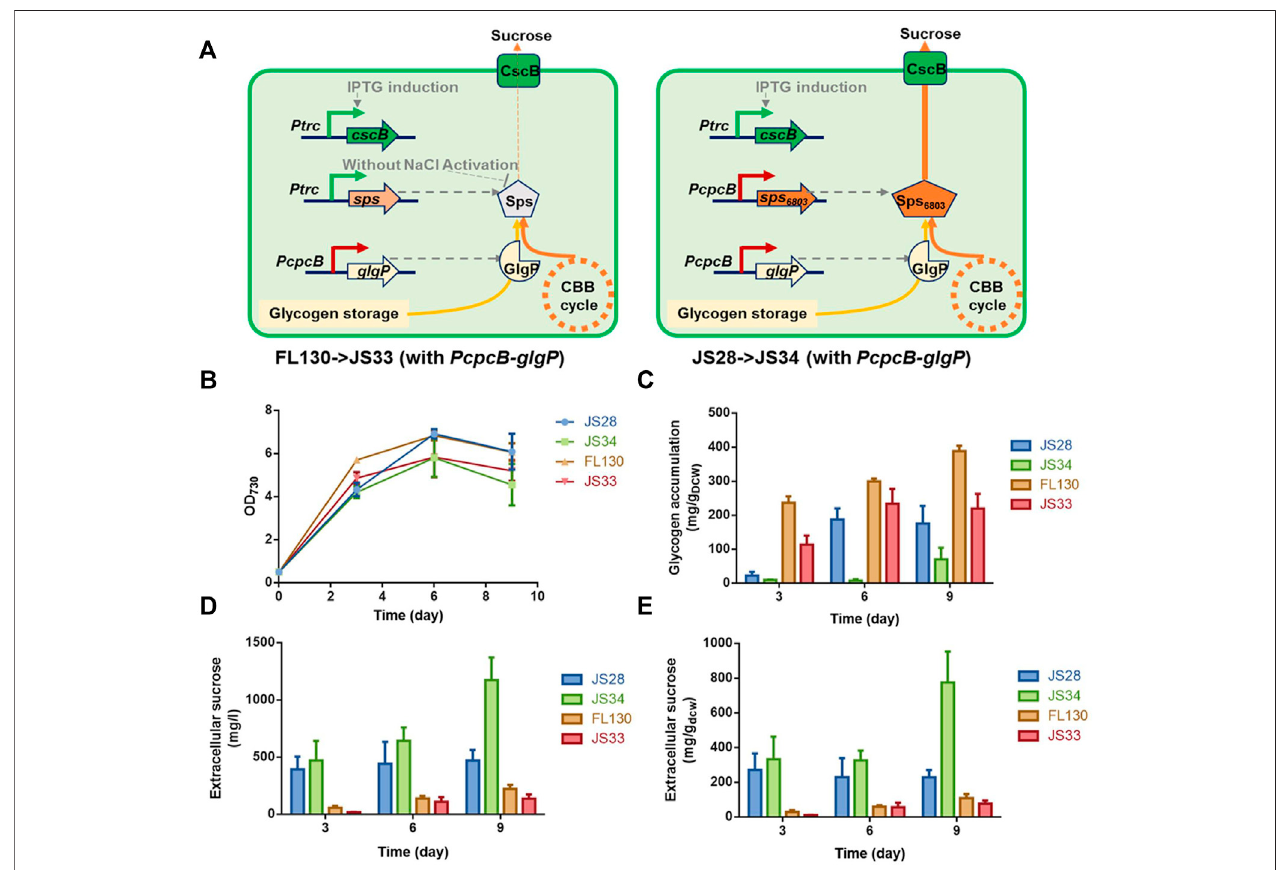
FIGURE 6 | Effects of glgP overexpression on sucrose synthesis of PCC 7942 cell factories under non-hypersaline conditions. (A) To facilitate sucrose synthesis under non-hypersaline conditions, the PCC 6803 sourced sps gene sps 6803 was put under the control of the PcpcB promoter to replace the Ptrc expressed native sps gene in FL130, and the obtained strain was termed as JS28. To enhance glgP expression, a PcpcB promoter – driven glgP expression cassette was introduced into FL130 and JS28, generating JS33 and JS34, respectively. Without salt stress induction, the Sps in FL130 and JS33 would be inactivated, and the sucrose synthesis would be inhibited. In JS28 and JS34, the NaCl-activation – independent Sps 6803 could normally catalyze the sucrose synthesis process. Cultivated in column photobioreactors instandardconditionswithoutsaltstress, (B) cellgrowth, (C) glycogencontents,and (D,E) sucroseproduction ofFL130,JS33, JS28,and JS34cells were calculated in 9